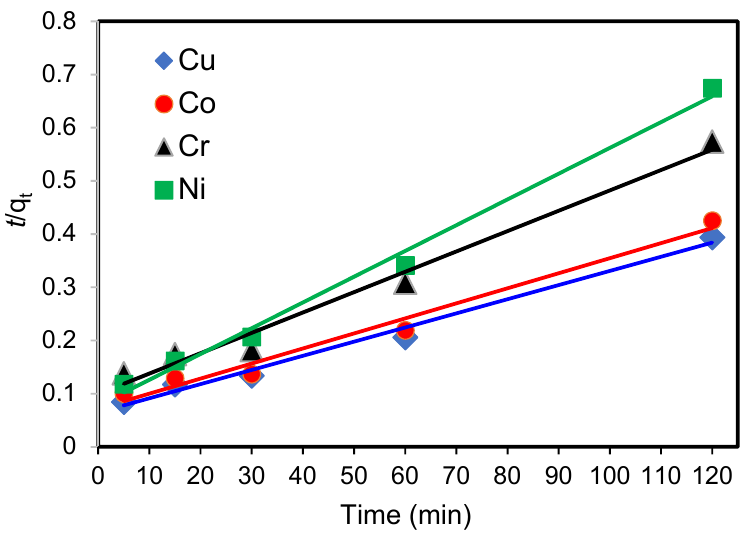
Table 2. Pseudo-second-order rate of adsorption of metal ions by poly(hydroxamic acid) ligand. Adsorbate